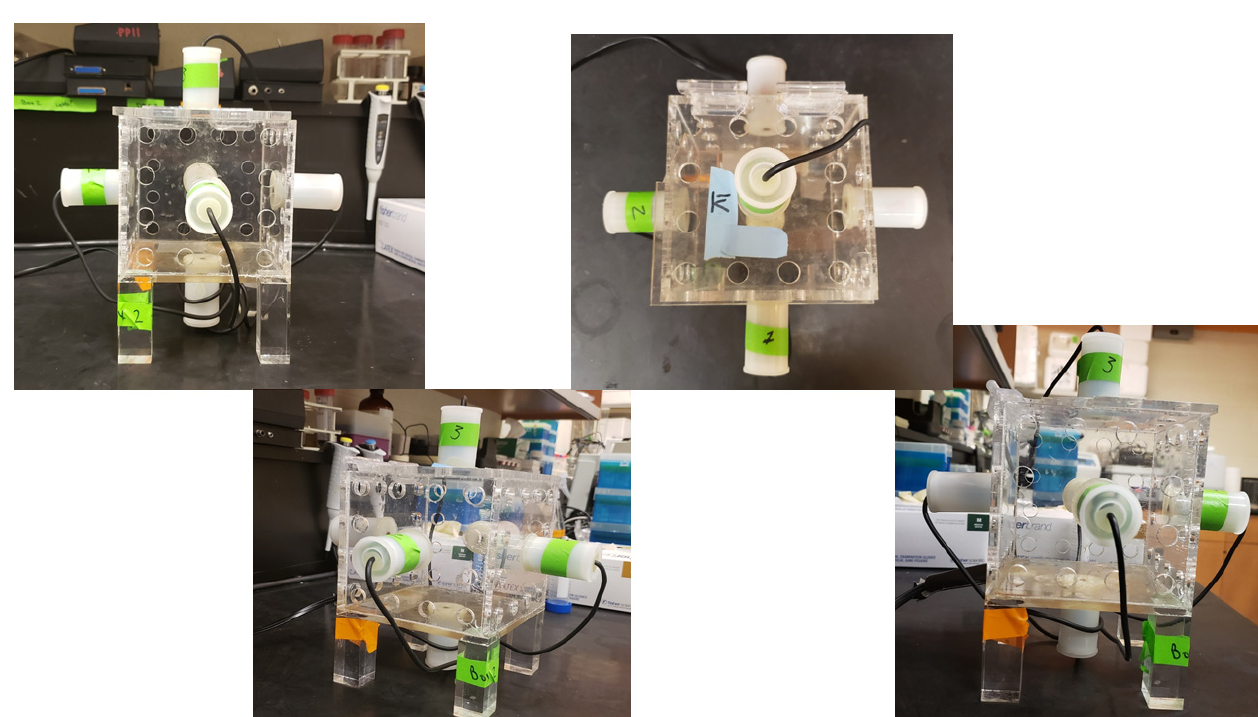
Figure A1. Photographic representation of the 4-D exposure apparatus from different points of view. Front (top left); Top (Top right), Corner (bottom left), side (bottom right).